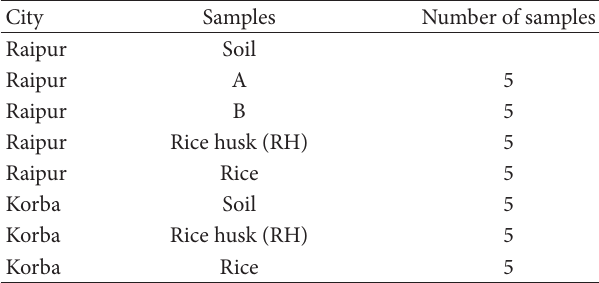
Table 1: Type of samples and their corresponding numbers sampled from the studied